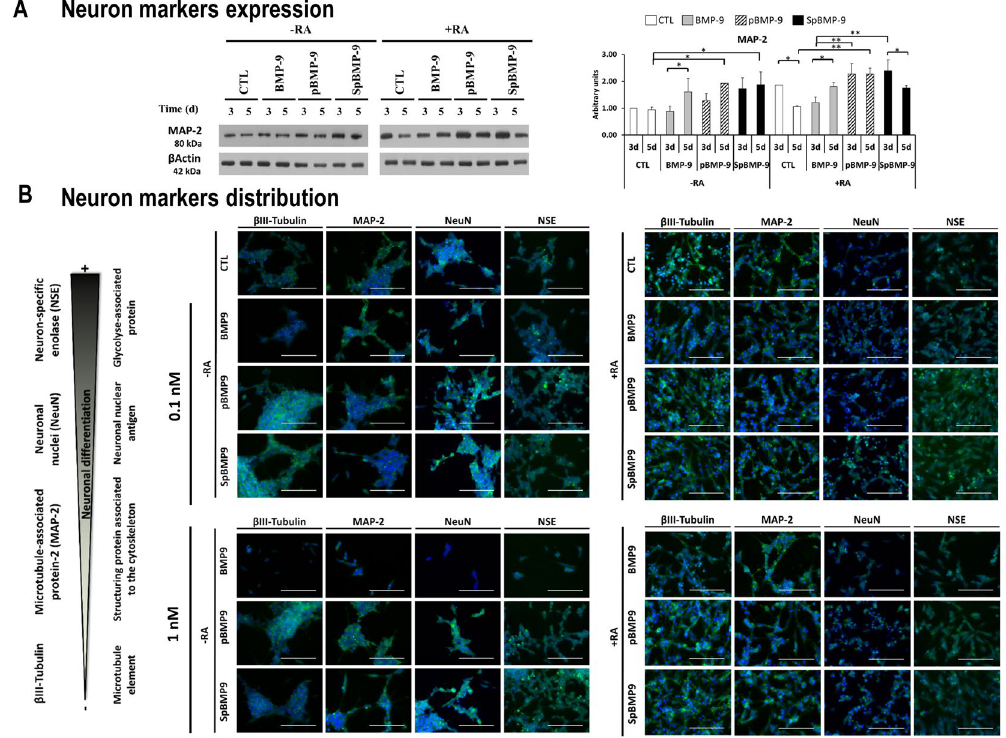
Figure 4. Effect of pBMP-9 and SpBMP-9 on the differentiation of SH-SY5Y cells. ( A ) Western blots of MAP-2 and β actin (2 independent experiments) and densitometric analyses of MAP-2 bands normalized to β actin (means ± SEM) for SH-SY5Y cells stimulated with 0.1 nM BMP-9, pBMP-9 and SpBMP-9 + / − 10 μ M RA for 3d and 5d ( * p < 0.05, ** p < 0.01). Only cropped pictures of western blots showing the 80 kDa MAP-2 isoform were presented in order to allow a better comparison between experimental conditions. Complete gel pictures are available in the supplementary data file. ( B ) Merged pictures showing immunostaining for neuronal differentiation markers β III-tubulin (Alexa Fluor ® 488, green), MAP-2 (Alexa Fluor ® 488, green), NeuN (FITC, green) and NSE (FITC, green), and nuclei staining (Hoechst, blue) of SH-SY5Y cells stimulated for 5d with 0, 0.1 or 1 nM BMP-9, pBMP-9 and SpBMP-9 + / − 10 μ M RA. Pictures are representative of at least two independent experiments (Bar = 100 μ